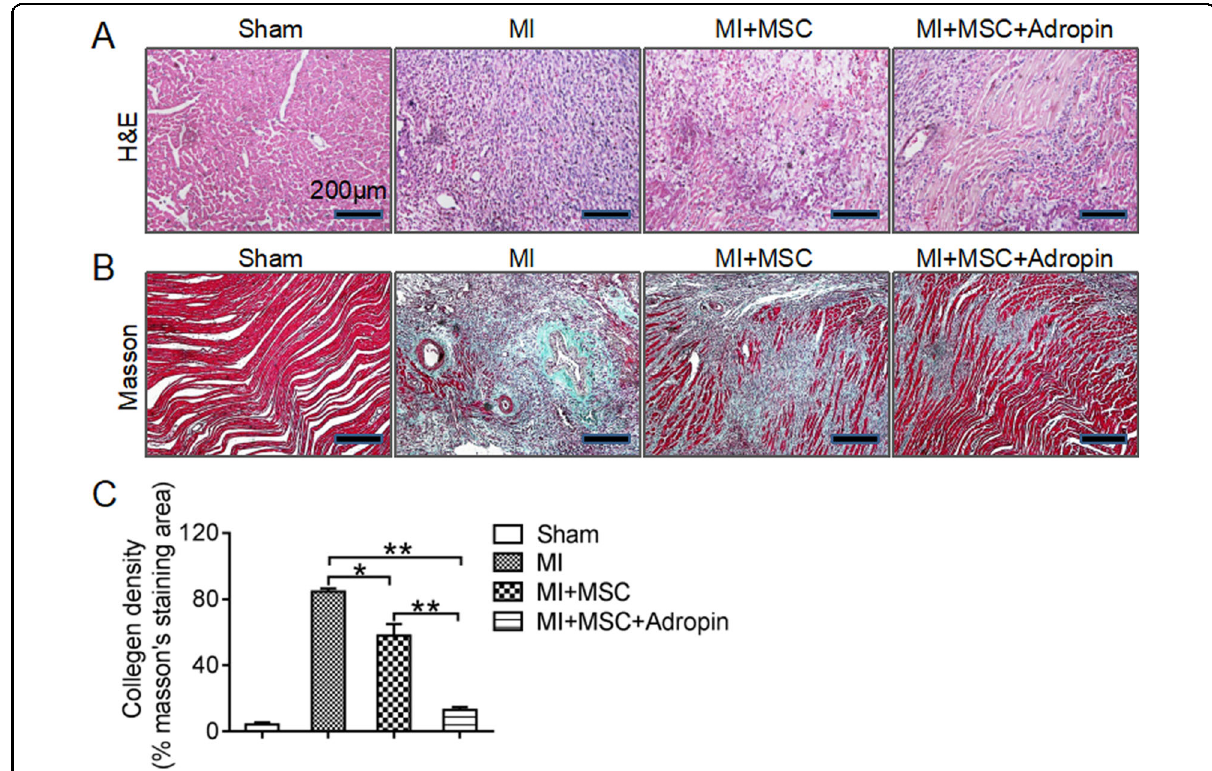
Fig. 3 Alleviated cardiac remodeling by adropin-based dual treatment with MSCs transplantation in rat myocardial infarction. A H&E staining (original ampli fi cation: ×200). B , C Masson ’ s trichrome staining was used to assess myocardial fi brosis, and typical images were shown in ( B ) (original ampli fi cation: ×100). MSCs and MI, see Fig. 1. Data are expressed as mean ± SD, n = 8. * p < 0.05; ** p <